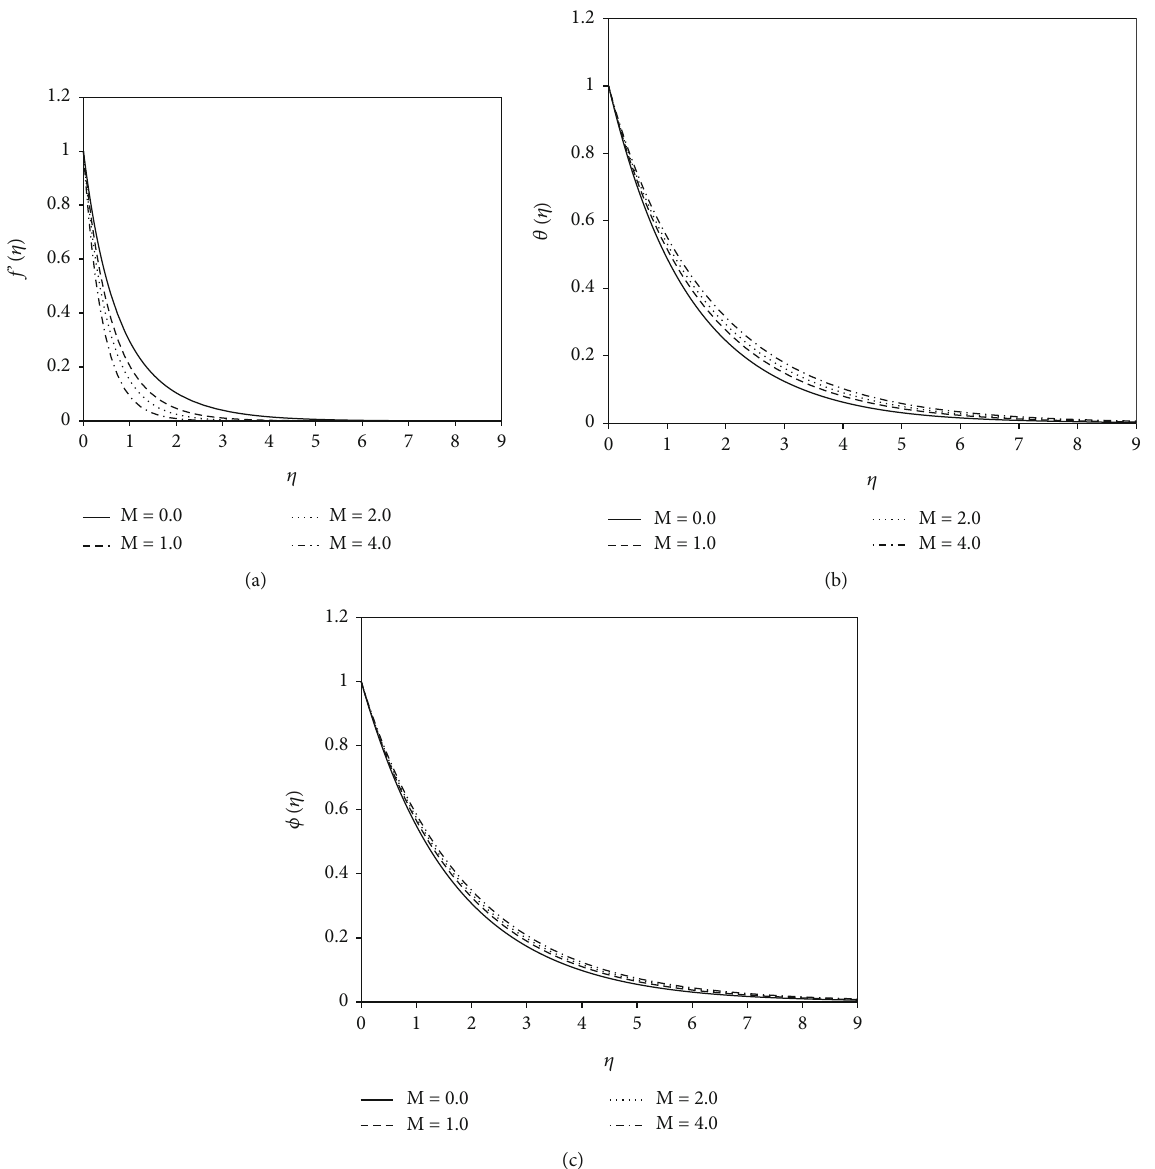
Figure 2: (a) Di ff erent values of M on the velocity pro fi le. (b) Di ff erent values of M on the temperature pro fi le. (c) Di ff erent values of M on the concentration pro fi